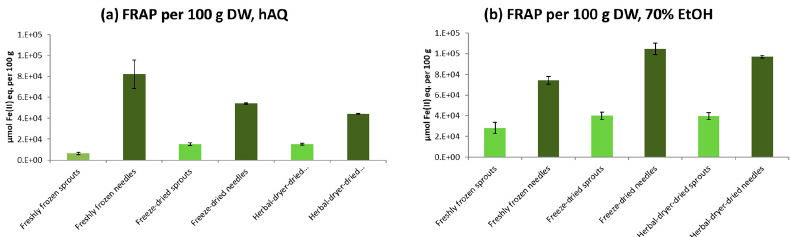
Figure 3. Ferric ion reducing antioxidant power (FRAP) of sprout and older needle raw materials (freshly frozen, freeze-dried, warm air-dried) of Norway spruce after water (hAQ) ( a ), and 70% ethanol (70% EtOH) ( b ) extraction. The results are calculated per 100 g dry weight (DW). The error bars indicate standard deviations. Molecules 2020 , 25 , x FOR PEER REVIEW